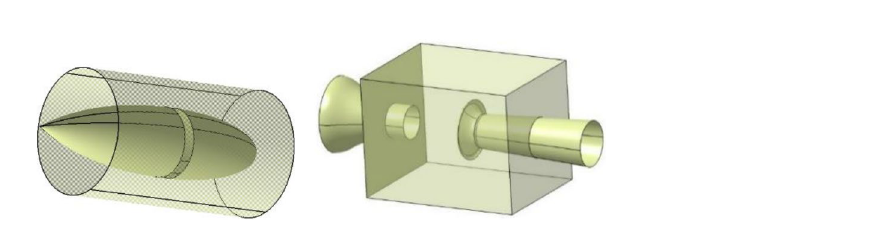
Figure 18. Simplified models of the fan and the chamber.